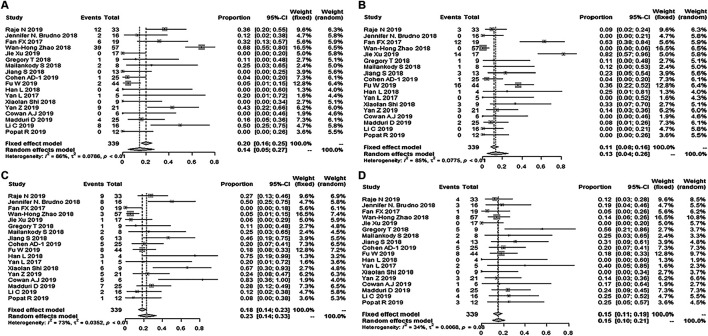
The forest plot of (A) pooled sCR, (B) CR, (C), VGPR, and (D) PR.